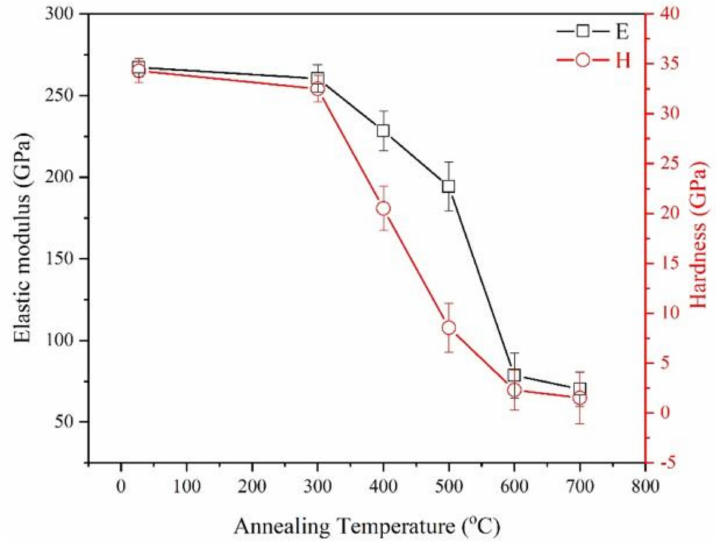
Figure 8. Hardness and elastic modulus of (CrTaTiVZr)N coatings after annealing at di ff erent temperatures in air.